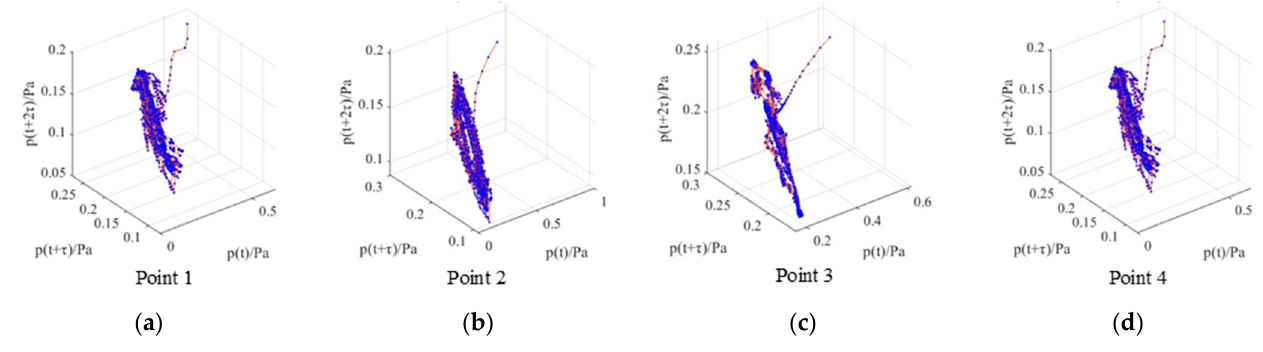
Figure 15. Phase space trajectories for A = 4 mm: ( a ) point 1; ( b ) point 2; ( c ) point 3; ( d ) point 4.